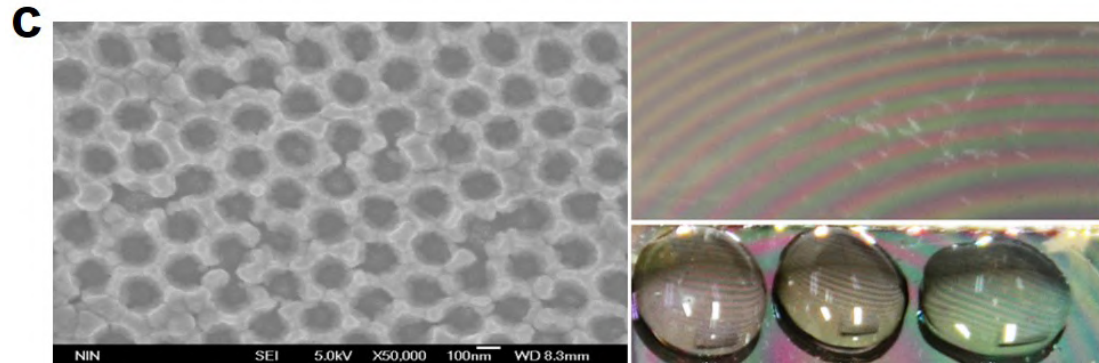
Figure 2. Optical metamaterial for sensing. ( a ) Schematic and SEM images of the 3D metasurface sensor, experimental optical extinction spectra w/o the top disk. Reproduced with permission from [64]. Copyright 2020, American Chemical Society. ( b ) SEM image of Na x WO 3 -based ENZ metamaterials UV-vis transmittance and normalized transmittance of Na0.6WO3 metamaterials at different environments and wavelengths. Reproduced with permission from [73]. Copyright 2018, American Chemical Society. ( c ) SEM image of the porous silver film, and the digital photographs of the sensor, and with water droplet, 15% glucose solution droplet, and 60% sucrose solution droplet. Reproduced with permission from [84]. Copyright 2013, American Institute of Physics.